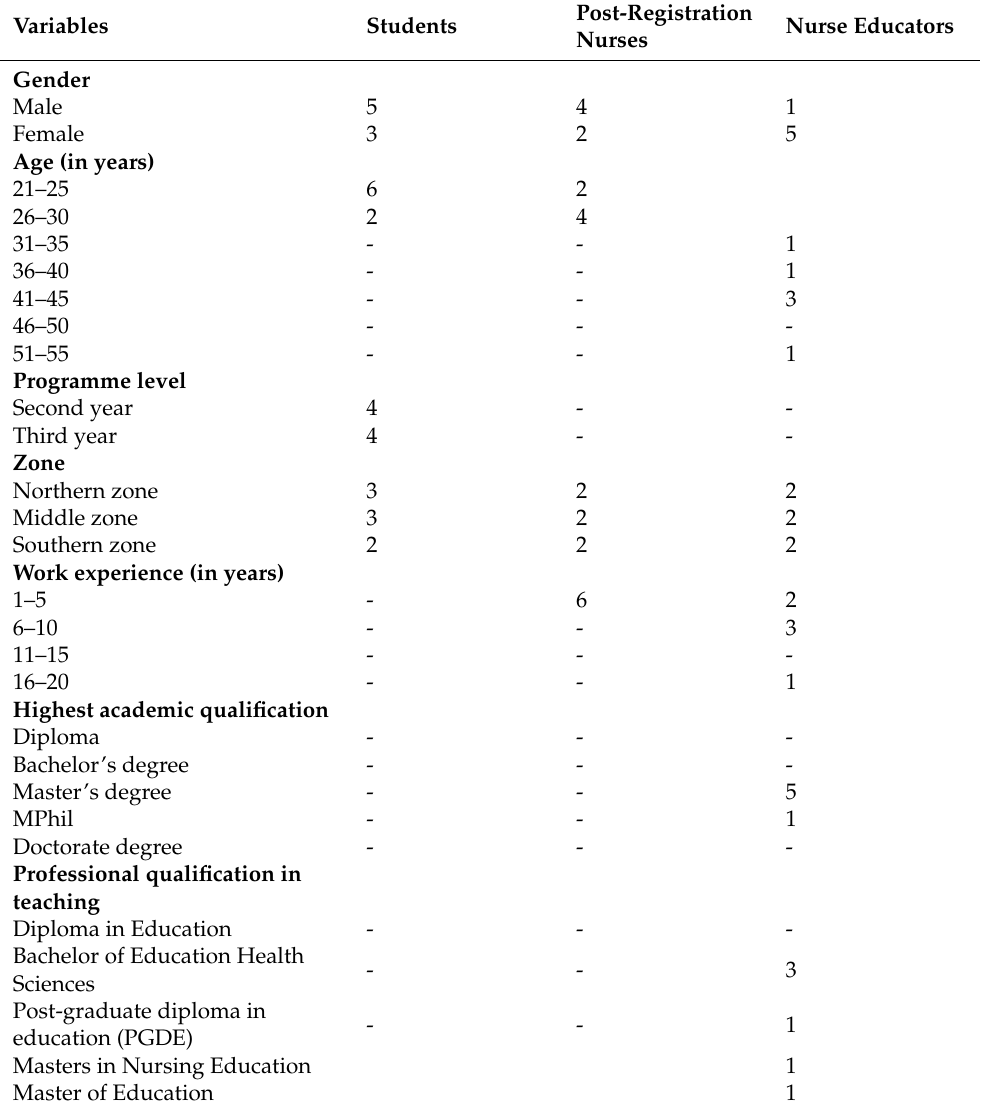
Table 3. Demographic characteristics of